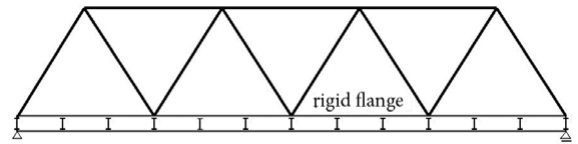
Fig. 1. Scheme of Warren truss with rigid bottom flange (cross beams are shown)